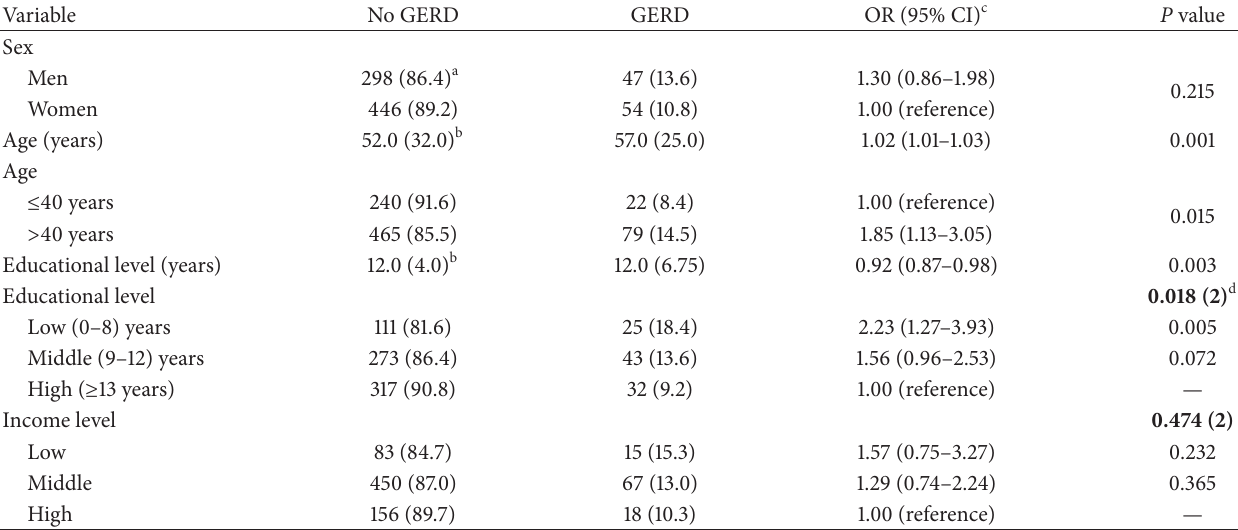
a Numbers and row percentages (in parentheses). Discrepancies in the totals are due to missing covariate values. b Median and interquartile range (in parentheses). c Unadjusted (crude) odds ratios (ORs: GERD versus no GERD), 95 % confidence intervals (95 % CIs), and P values from binary logistic regression. d Overall P value and degrees of freedom (in